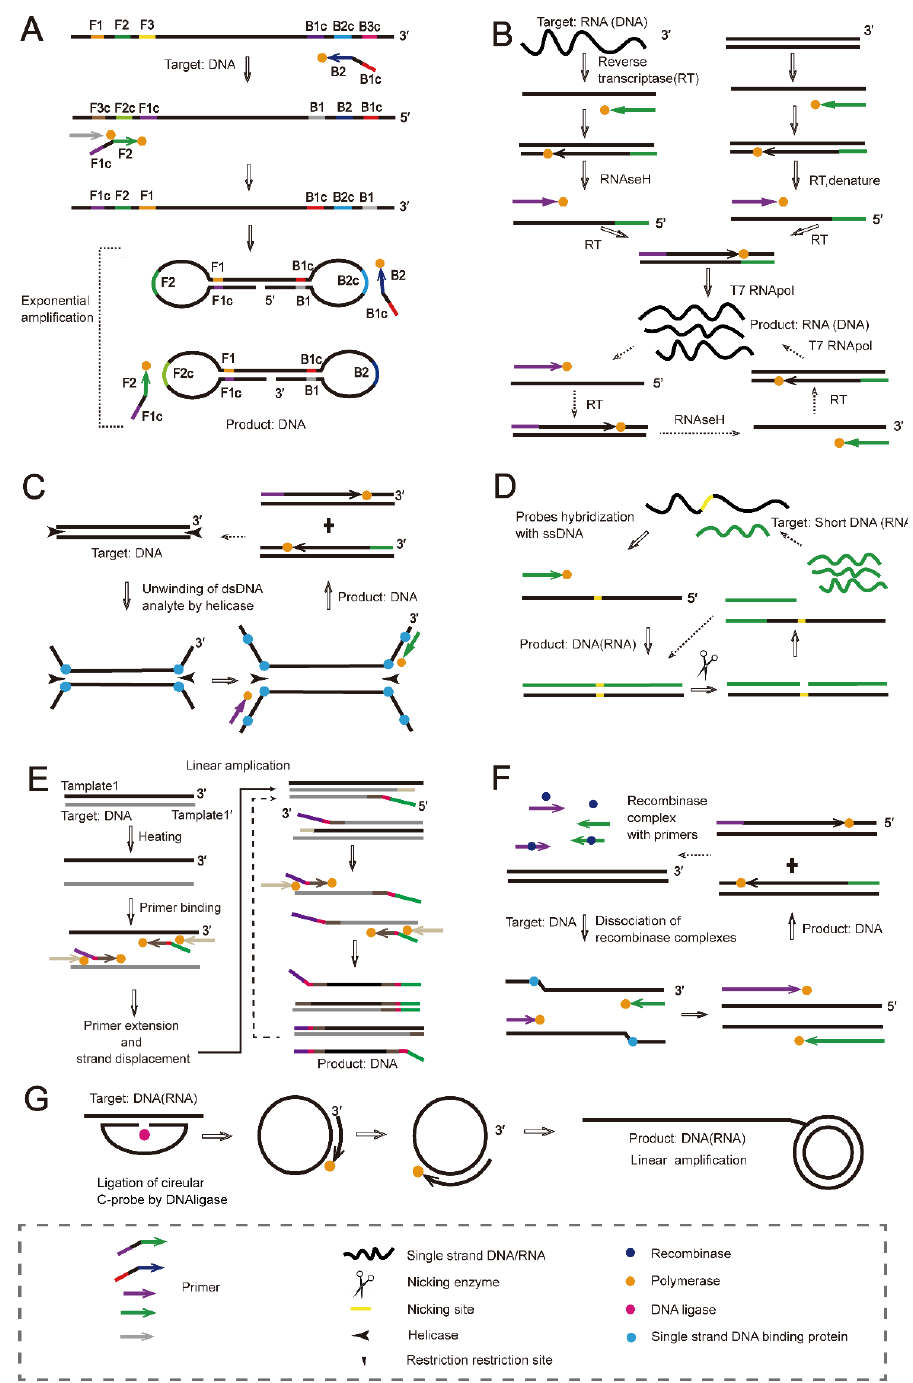
Figure 1. Partial isothermal amplification techniques: ( A ) loop-mediated isothermal DNA amplification (LAMP); ( B ) nucleic acid sequence amplification (NASBA); ( C ) helicase-dependent DNA amplification (HDA); ( D ) exponential amplification reaction (EXPAR); ( E ) linear strand displacement amplification (SDA); ( F ) recombinase polymerase amplification (RPA); ( G ) linear rolling circle amplification (RCA).